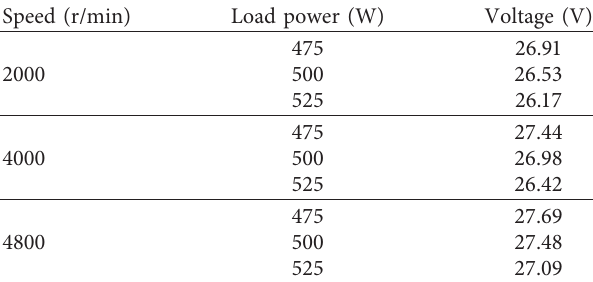
Table 5: Test results of output stable